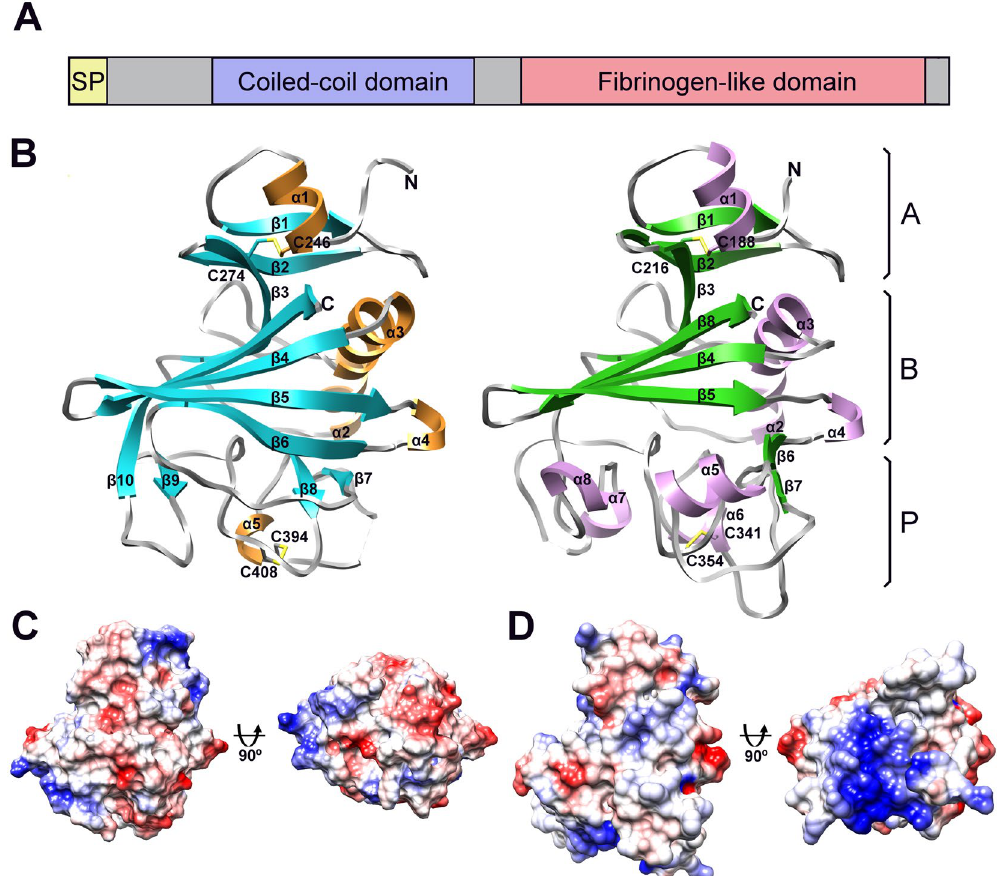
Figure 1. Crystal structure of the fibrinogen-like domains of Angptl3 and Angptl4. ( A ) Schematic of Angiopoietin-like protein domain architecture. Each angiopoietin and angiopoietin-like protein (except Angptl8) contains an N-terminal region predicted to be intrinsically disordered, a coiled-coil region and a C-terminal fibrinogen-like domain. ( B ) Structure of Angptl3 (left) and Angptl4 (right) fibrinogen-like domains. Each can be split into three subdomains A, B and P. Each structure is colored according to secondary structure elements with α -helices in gold (Angptl3) and violet (Angptl4), β -strands in cyan (Angptl4) and green (Angptl4) and loops in grey. Missing sections in the loops are indicated by dashed lines. Secondary structure elements are labeled and the N- and C-termini are indicated. ( C ) Electrostatic surface potential of Angptl3, the orientation is equivalent to that in panel B and rotated 90° around horizontal axis to see the underside of the P subdomain. Negative charge is shown in red and positive in blue. ( D ) As panel C but